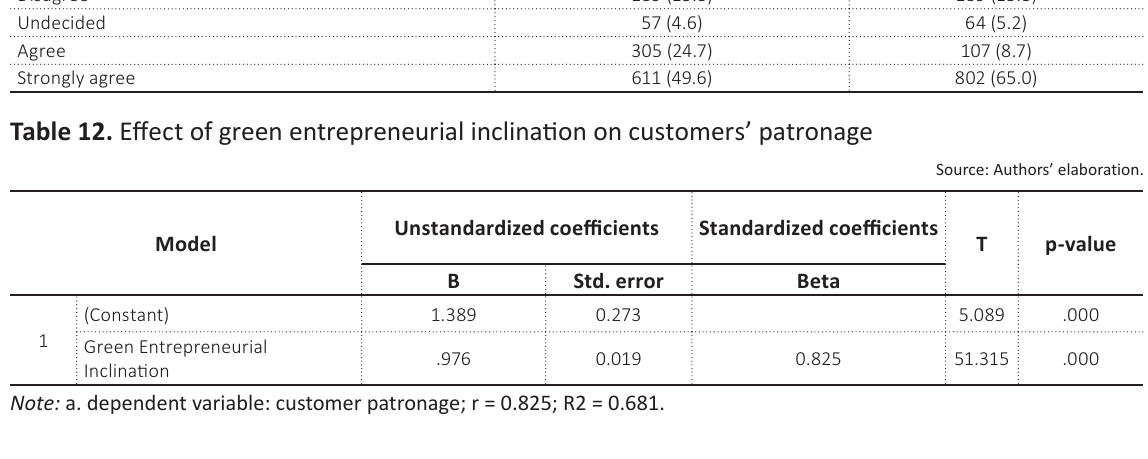
Table 11. Consolidated responses to questions related to the second hypothesis